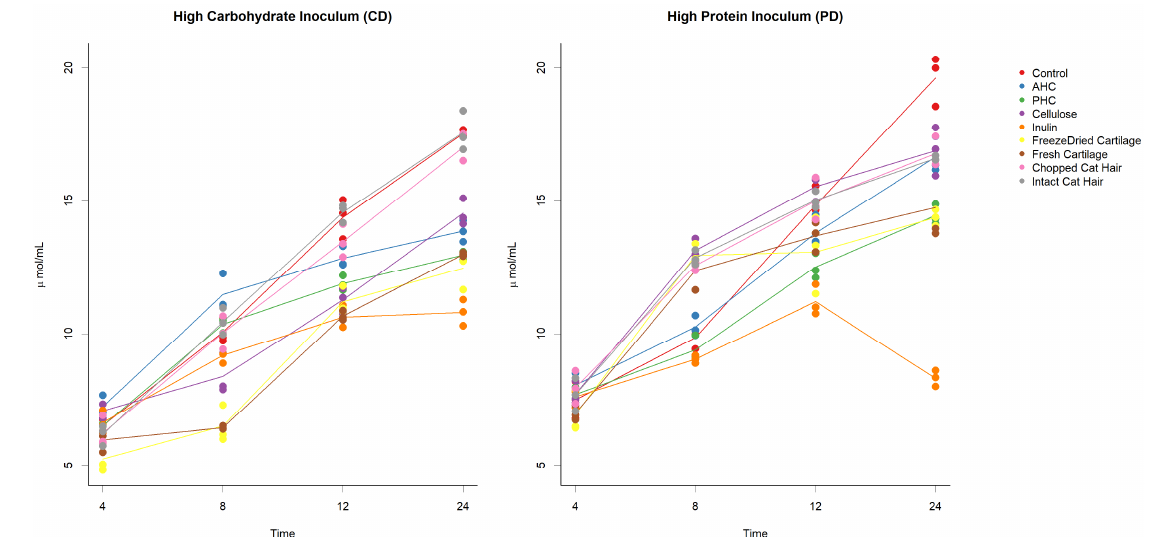
Figure 2. Scatter plots with mean lines of ammonia concentrations. Time (hours) is along the x -axis and organic acid concentration along the y -axis (mM). Each graph depicts both high protein faecal inoculum (PD) and high carbohydrate faecal inoculum (CD) and the changes that occurred over 24 h of fermentation. Each point (coloured circle) represents an individual replicate, and each line shows the mean for each substrate. Control samples are denoted by a red line, AHC (ANZCO hydrolysed collagen) by a blue line, PHC (Peptan hydrolysed collagen) by a green line, cellulose by an orange dashed line, inulin by a purple line, freeze-dried cartilage by a yellow line, fresh cartilage by a brown line, chopped cat hair by a pink line, and intact cat hair by a grey line.